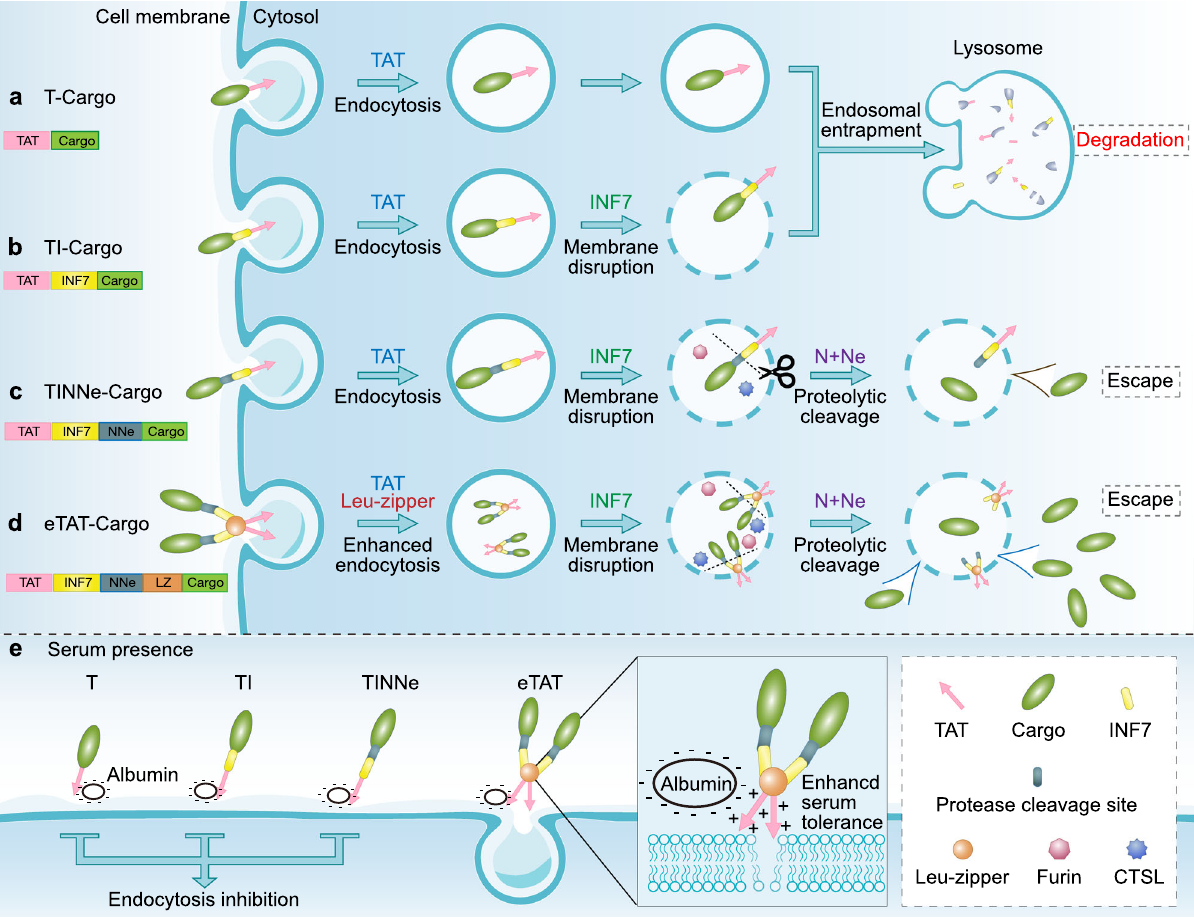
Fig. 5 Schematic illustration of intracellular delivery mediated by eTAT and other TAT-based methods. a The fi rst step of intracellular delivery is the electrostatic interaction between TAT and membrane components on the cell surface (e.g. glycosaminoglycans), and then, cargos are internalised via TAT- induced endocytosis. However, T-cargos are entrapped in endosomes, and the majority of the cargo is ultimately targeted to lysosomes for degradation. b Even when the endosomal membrane is disrupted by INF7 (TI-Cargo), the majority of the cargo remains entrapped in endosomes because of the interaction between the endosomal membrane and TAT and/or that between the endosomal membrane and INF7. c When the proteolytic sites N and Ne are cleaved by endosome-localised proteases cathepsin and furin, the cargo is separated from TAT-INF7 and released rapidly from the disrupted endosome (TINNe-Cargo) into the cytosol. d, e The leucine zipper (LZ) can induce the formation of homodimers of the eTAT-cargo (TINNeL-cargo), which results in improved endocytosis ( d ) and weakened competitiveness of serum protein albumin ( e ) via increased local concentration of TAT that can interact with the cellular membrane components. CTSL: cathepsin